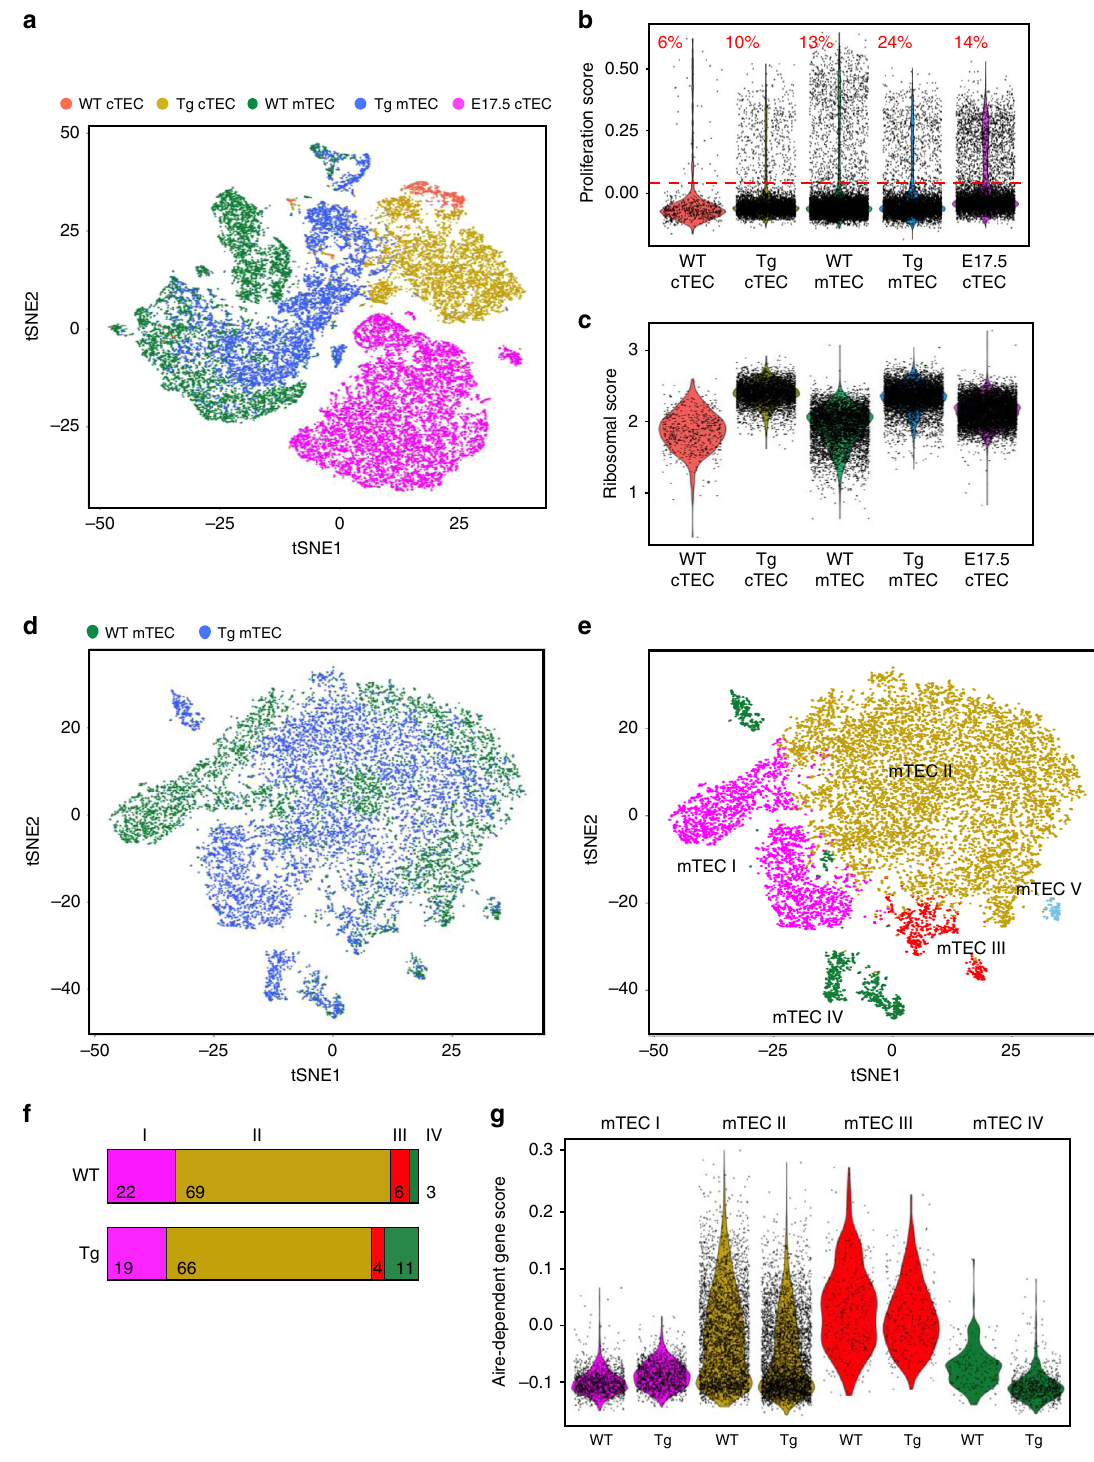
Fig. 5 Transgenic Myc confers expression of a limited set of fetal-speci fi c genes in adult TEC. scRNA-seq analysis performed on cTEC (CD45 − EpCAM + Ly51 + UEA − ) or mTEC (CD45 − EpCAM + Ly51 − UEA + ) isolated from adult WT or FoxN1MycTg mice, and a cTEC sample from embryonic day 17.5 (E17.5 cTEC). a A t-SNE representation of the populations, colored and clustered by original identity. b A violin plot of the proliferation score for the indicated populations. The red line separates cells based on their proliferation score, high score above the line and low score below the line, percentages of cells above the line are indicated in red. c A violin plot of the ribosomal score applied to the indicated populations. d , e A t-SNE representation, regressed out for cell cycle, of WT and FoxN1MycTg mTEC populations, colored and clustered by original identity ( d ) or gene expression similarity ( e ). f The fraction of four (of the fi ve) mTEC clusters identi fi ed in ( e ), for WT mTEC (above) or FoxN1MycTg mTEC (below) samples. The colors of the bars correspond to colors allocated to the four clusters in the t-SNE plot displayed in ( e ). g A violin plot of the Aire-dependent gene score of either the WT or FoxN1MycTg cells that make up each of the four indicated mTEC